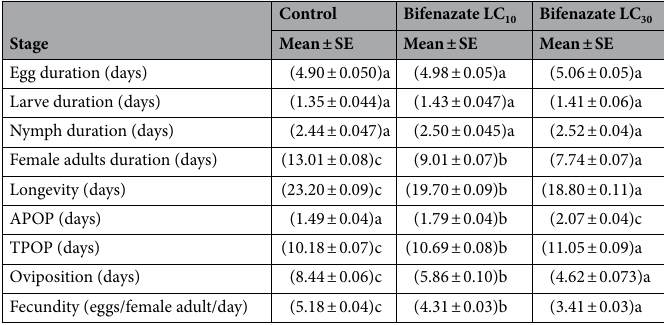
Table 2. Life tables of Panonychus citri exposed to low lethal concentrations of bifenazate. APOP adult pre- ovipositional period, TPOP total pre-ovipositional period (from egg to first oviposition). Means in a row followed by the same letter are not significantly different by the boostrap paired test ( p > 0.05).